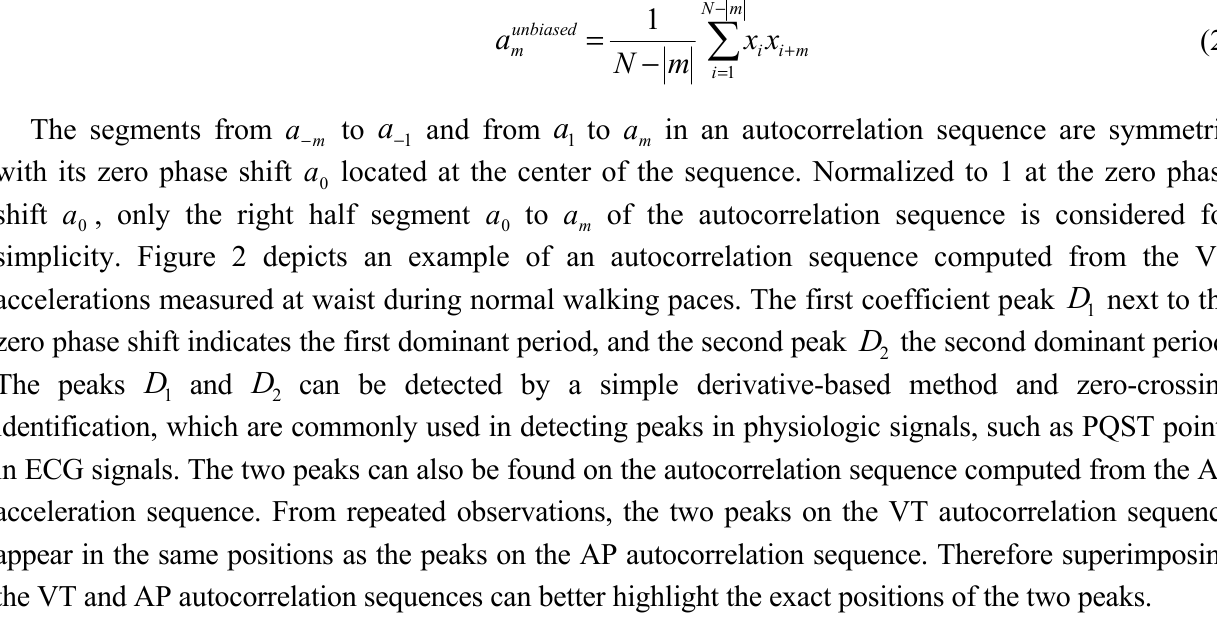
Figure 2. The example of an autocorrelation sequence computed from the vertical acceleration measured at waist during